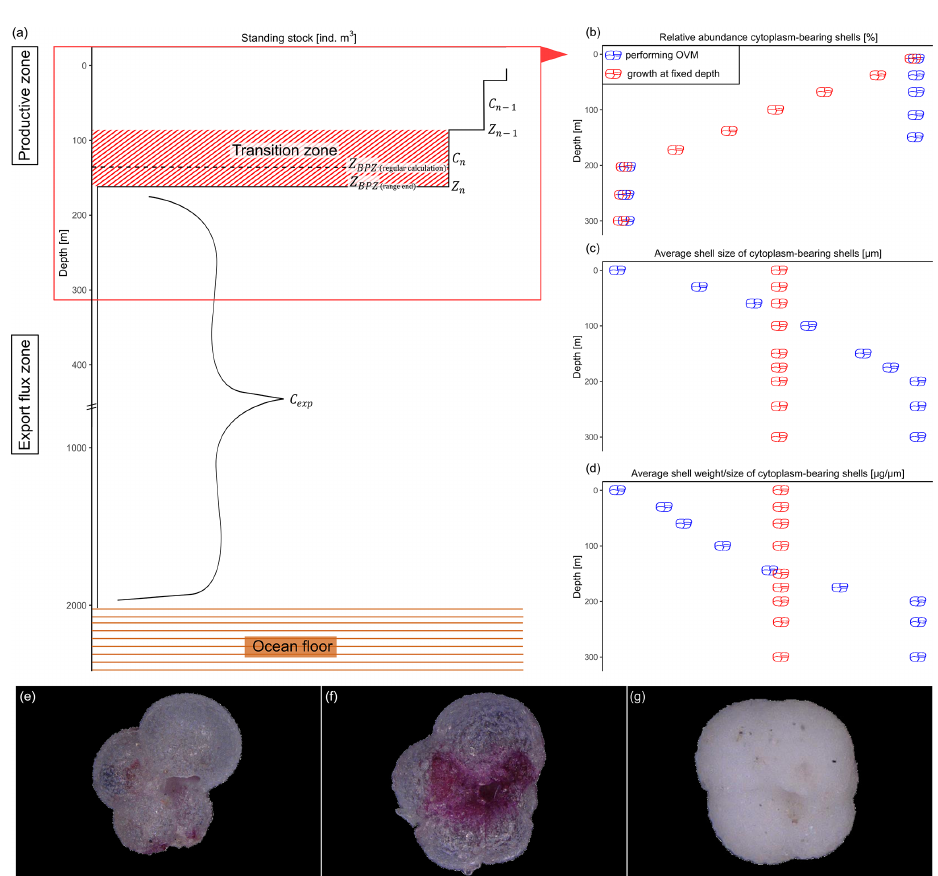
Figure 2. Schematic overview of the studied shell parameter. Shown values are constructed numbers to represent the concept of the study and unmeasured values. (a) Change in standing stock of planktonic foraminifera with increasing depth. The parameters used to calculate the base of the export zone ( Z BPZ ) after Lonˇcari´c et al. (2006) are shown: the transition zone represents the area in which the foraminifera shell abundance ( C n ) rapidly changes, with rather stable abundances in the area below ( C exp ). Z n and Z n − 1 represent the start and end depths of the transition zone, in which the calculated BPZ is located. For details on the calculation, see Sect. 2.2. Panels (b) , (c) and (d) show the change in average (b) relative abundance of cytoplasm-bearing shells, (c) average shell size and (d) average calcification intensity (shell weight / size) of cytoplasm-bearing shells with increasing water depth within the productive zone. Blue symbols represent the ideal situation if N. pachyderma performs ontogenetic vertical migration (OVM) throughout its life cycle, while red shell symbols indicate the expected trend when individual specimens grow their shell at a fixed depth. Panels (e) , (f) and (g) show different types of encrustation of N. pachyderma , with (e) representing a non-encrusted shell, (f) the beginning of encrustation and (g) thick encrustation with a clearly different and more rounded